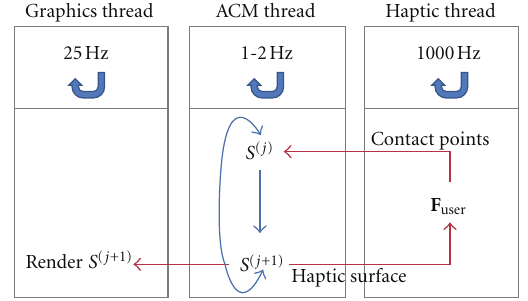
Figure 3: Diagram of the separate parts involved in the system. The ACM thread performs the ACM segmentation influenced by the . After performing one iteration forces provided by the user F user i j of the segmentation, the ACM thread provides the new shape S j +1 to the graphics rendering and haptic rendering